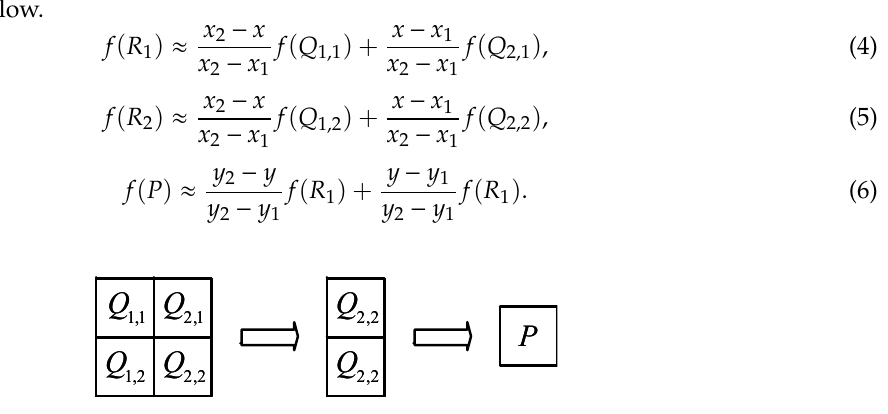
Figure 3. The vibration signal converted to a time–frequency representation (TFR) image by continuous wavelet transform: ( a ) waveform for the sample in normal conditions; ( b ) TFR image for the sample in normal conditions; ( c ) waveform for the sample with an inner raceway fault; ( d ) TFR image for the sample with an inner raceway fault; ( e ) waveform for the sample with a ball fault; ( f ) TFR image for the sample with a ball fault; ( g ) waveform for the sample with an outer raceway fault; ( h ) TFR image for the sample with an outer raceway fault.